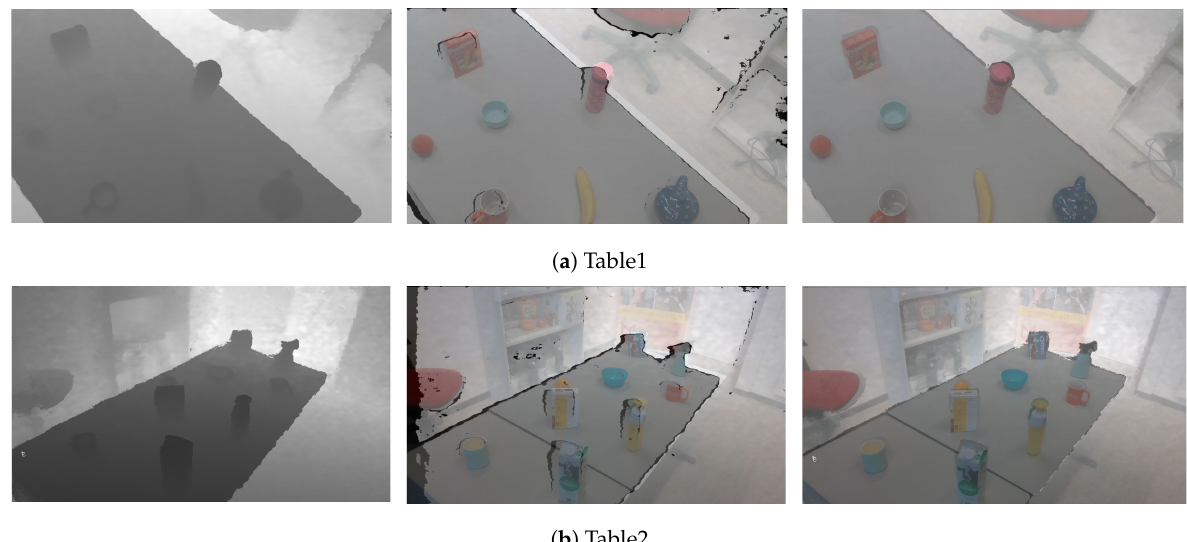
Figure 10. Examples of depth alignment results on table1 and table2 scenarios. The first column is the aligned depth image, the second column is the matching between captured depth and color images, and the third column is the matching between aligned depth and color images. The black color is the missing information.